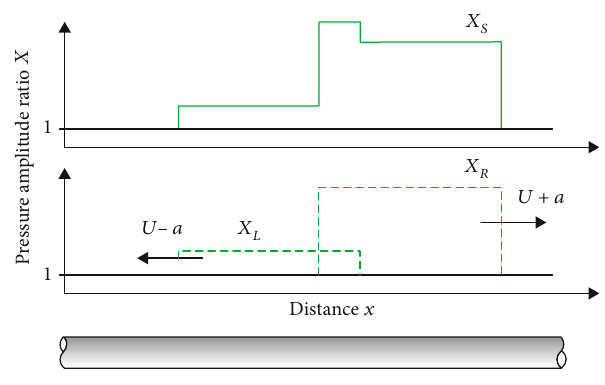
Figure 3: Acoustic waves traveling in